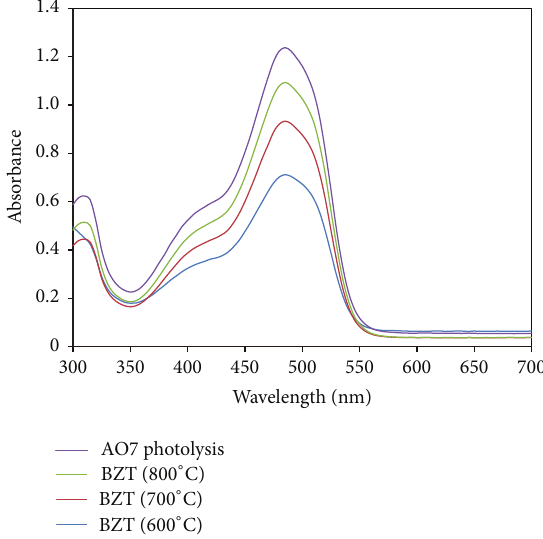
= 485 nm) after max photocatalytic degradation for 60min under UV irradiation in the presence of the BZT catalysts prepared at various